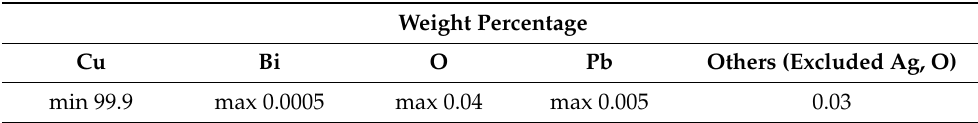
Table 1. Chemical composition of Cu-ETP [14].